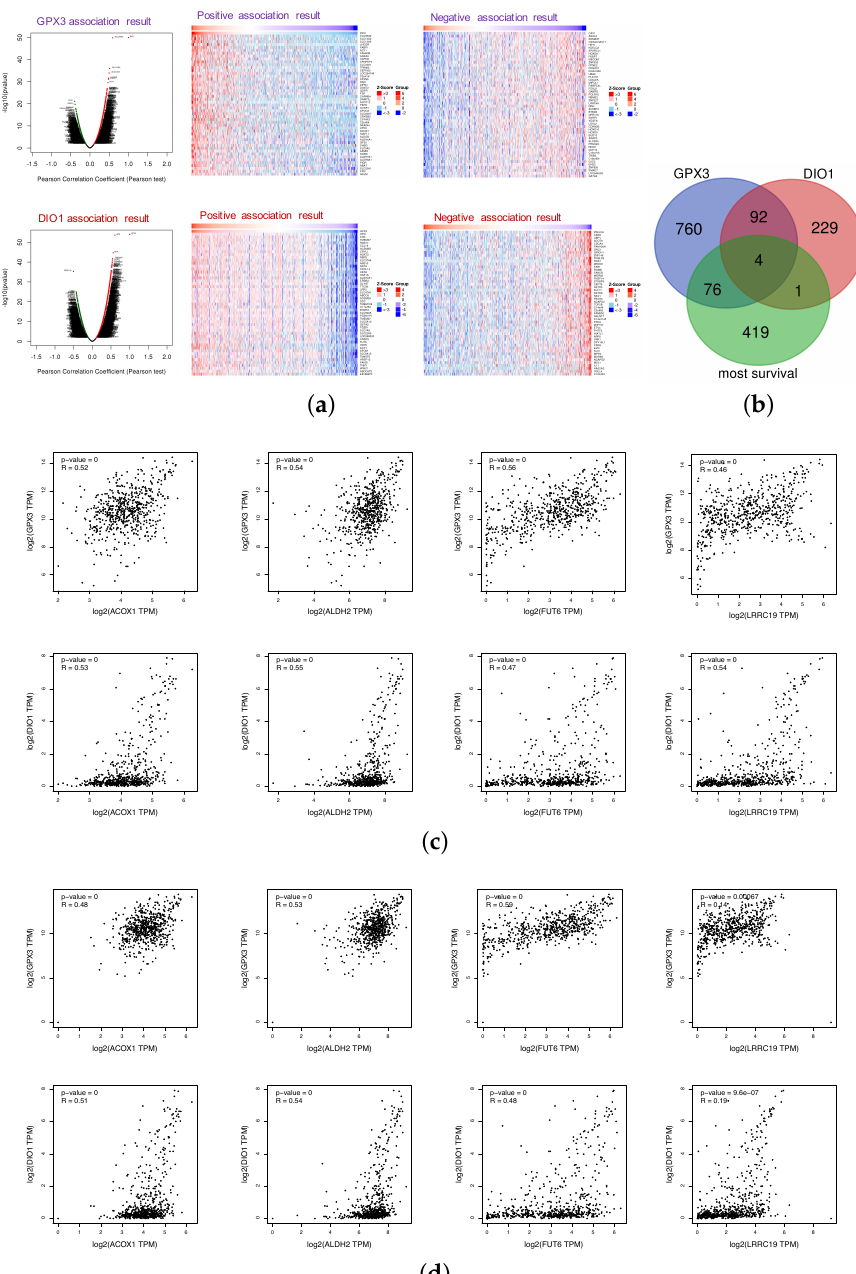
Figure 4. Most survival genes in correlation with GPX3 and DIO1 in KIRC. ( a ) Association results of GPX3 and DIO1 in KIRC ( n = 533); Pearson test was performed to analyze LinkFinder . Volcano plots show the statistical association results of GPX3/DIO1 for all KIRC differential expression genes, and individual genes of interest can be obtained in Table S1. Data for the top 50 positive and negative association genes are visualized in heat maps, respectively. ( b ) Venn diagram shows the mapping results among KIRC most common survival genes (green), GPX3 (purple), and DIO1 (pink) associated gene lists. There were four genes, namely ACOX1, ALDH2, FUT6, and LRRC19, in the intersection of the three datasets. ( c ) Correlation results of intersection genes with GPX3 and DIO1 based on datasets of “KIRC ( n = 523) + TCGA normal cases ( n = 72)”, using Pearson test. ( d ) Correlation analysis of intersection genes with GPX3 and DIO1 using data from “KIRC ( n = 523) + TCGA normal cases ( n = 72) + GTEx kidney cortex samples ( n = 28)”, using Pearson test. The association results with Pearson correlation coefficient ( R ) > 0.3 and p < 0.05 were considered significant